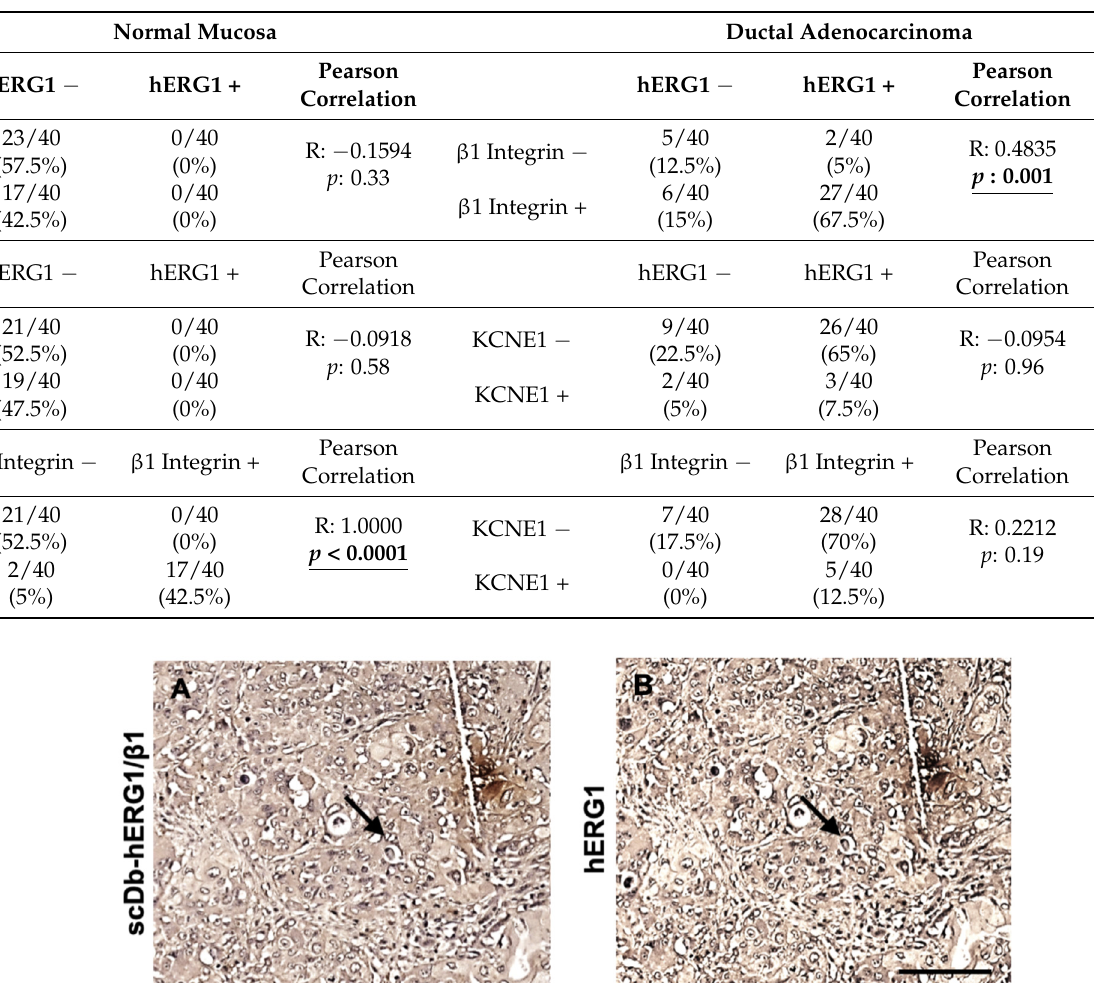
Table 1. hERG1, β 1 integrin and KCNE1 expression in normal mucosa and pancreatic adenocarcinoma primary tissues. Absolute values and percentages (in parentheses) are indicated. R and p values of Pearson correlation coe ffi cient are reported. Cut-o ff is de fi ned as the number of positive cells. Statistically signi fi cant p values are in bold and underlined.